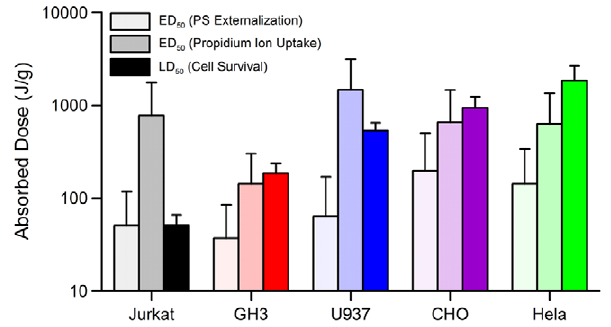
Figure 8. Cell size in tested cell lines as estimated by forward light scattering. Bar height represents the mean of three samples of each cell line and the error bars represent the standard deviation.